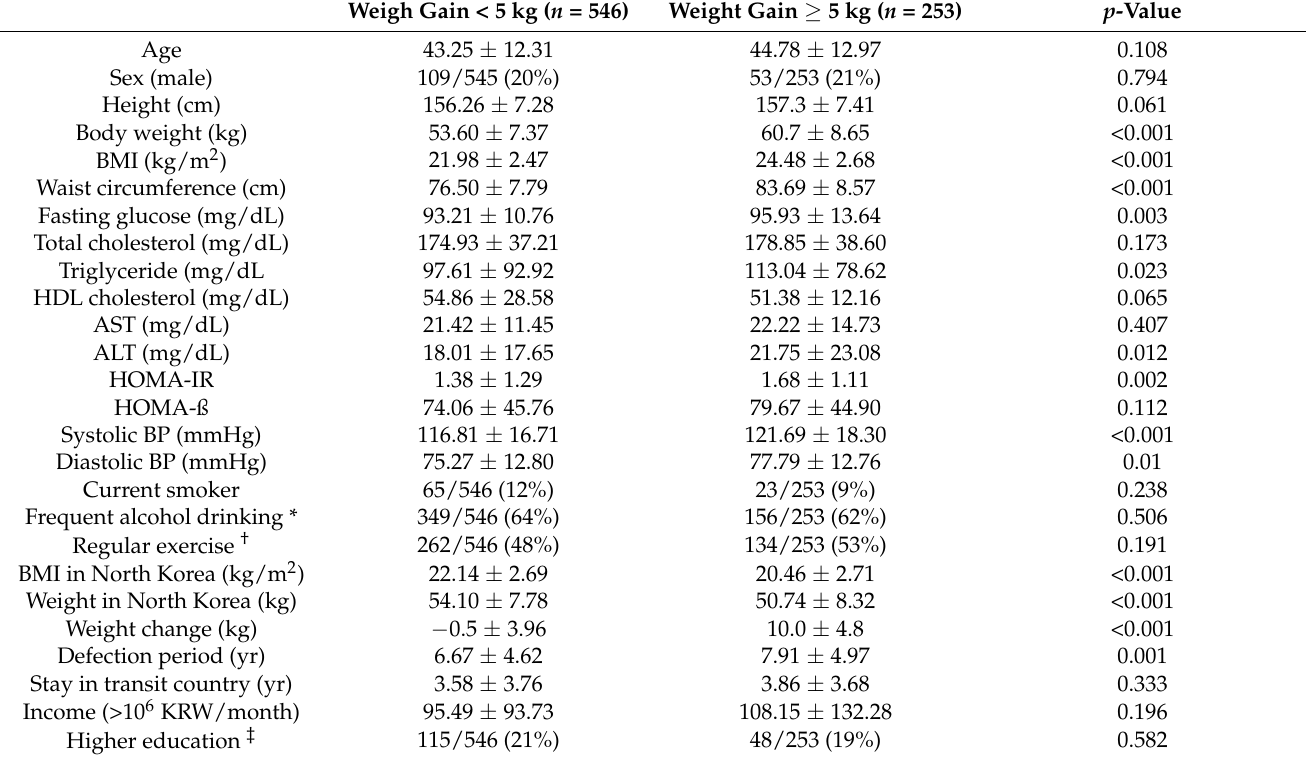
Table 1. Characteristics of North Korean refugees according to degree of weight gain.